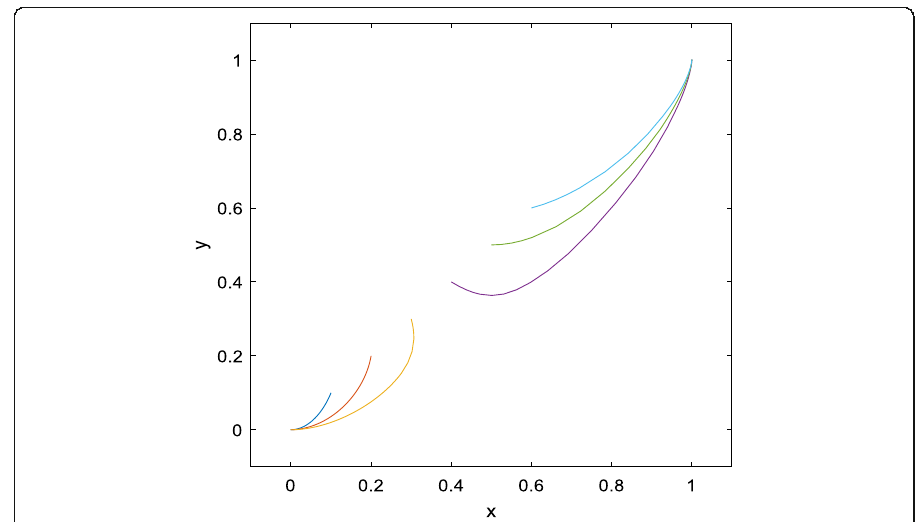
Fig. 8 Evolutionary game of the system with different initial values. Source: Authors ’ processing using Matlab